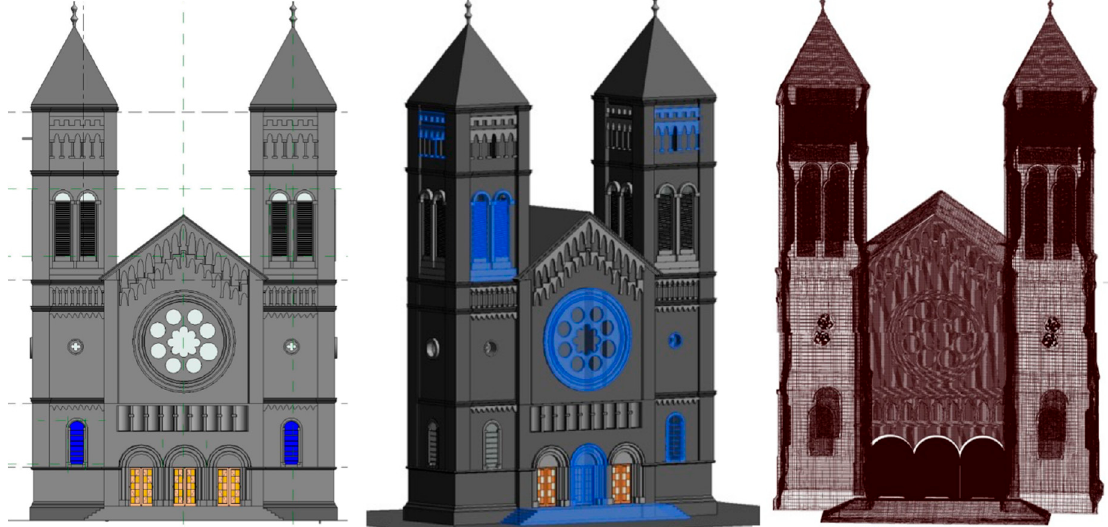
Figure 10. The final HBIM models in 2D and 3D views using manual scan-to-HBIM (left and middle) and semi-automated mesh-to-HBIM and semi-automated mesh-to-HBIM (right).